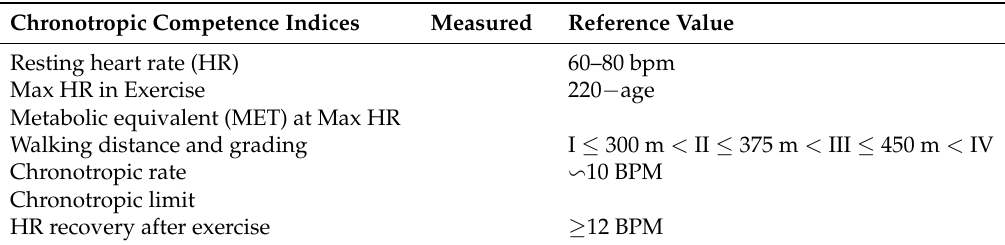
Figure 2. Curves of heart rate variation against exercise intensity during the entire 8 min walking test. Table 1. 3CT chronotropic competence indices (CCI) report